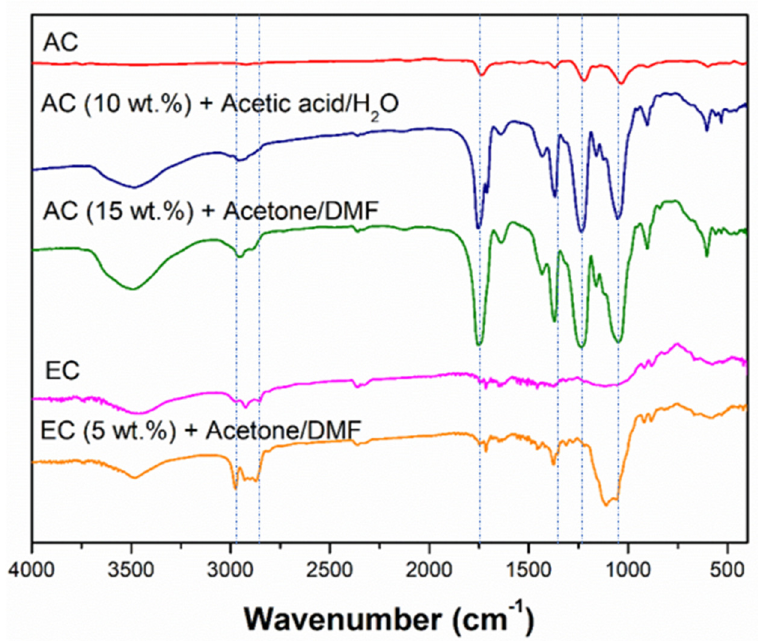
Figure 2. FTIR spectra of both raw materials (AC and EC) and selected nanostructures of the different systems. The dashed lines marked the most representative peaks that have been analyzed.